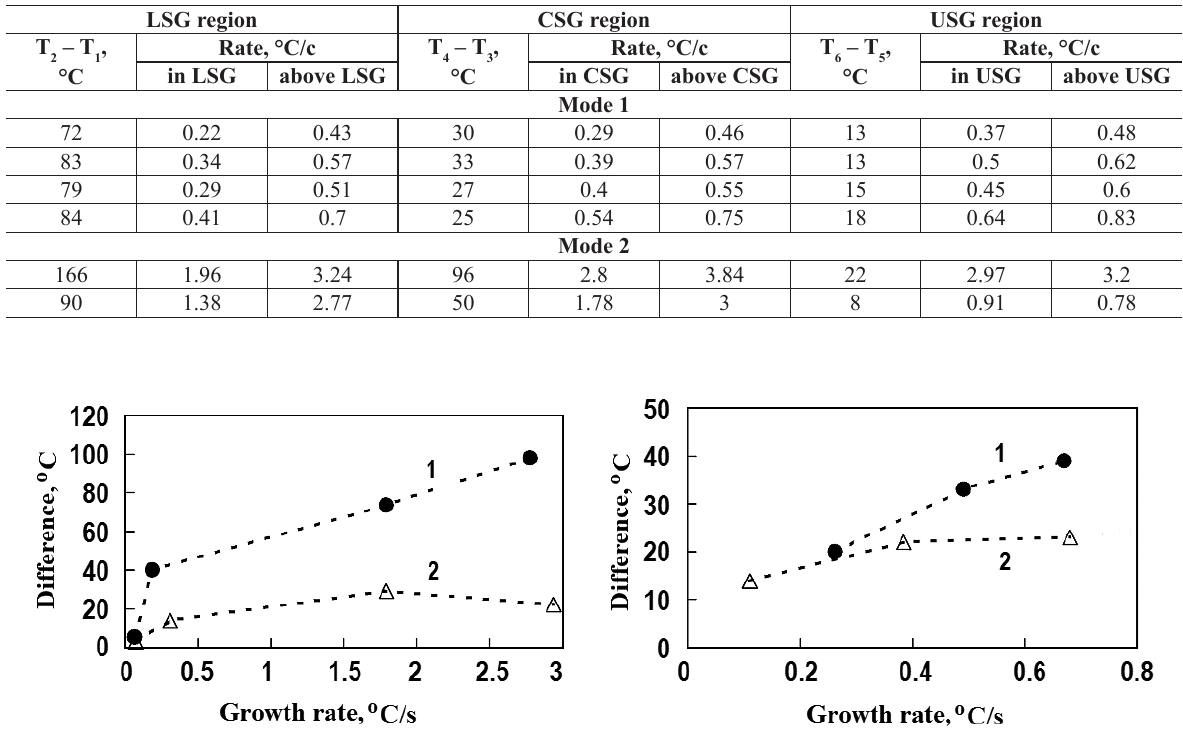
– Т , Т – Т as a function of the rate of growth in the TET readings 4 3 6 5